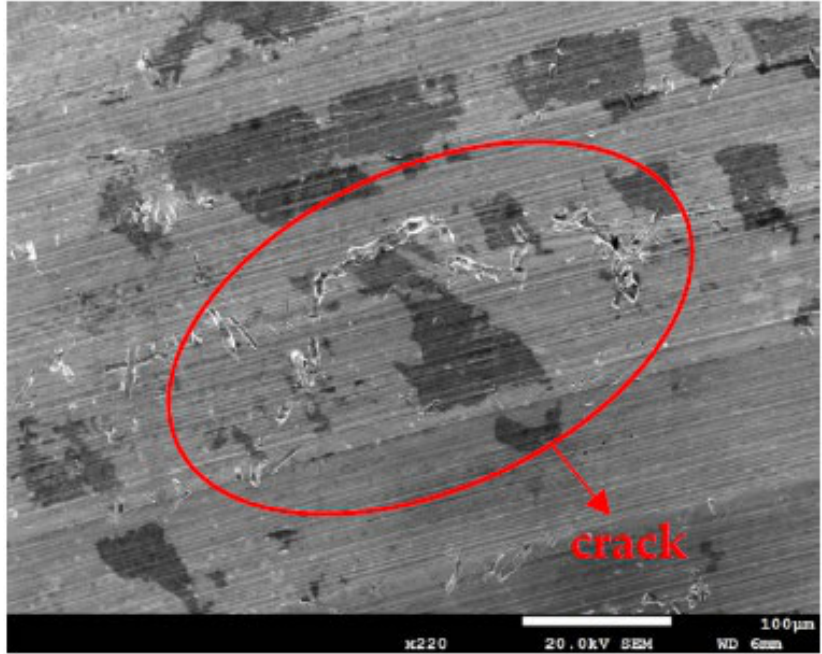
Figure 10. SEM morphology of the SCC in those samples with 0.1 g/m 2 of chloride deposited after 7000 h of testing at RH = 70%.